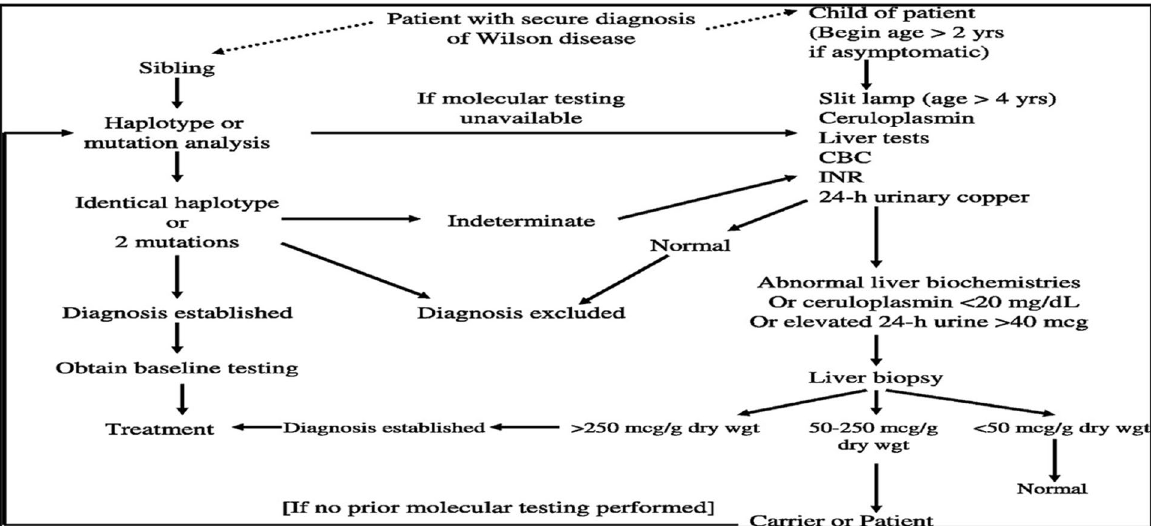
Fig. 2 Screening for Wilson disease in a sibling/child of diseased WD